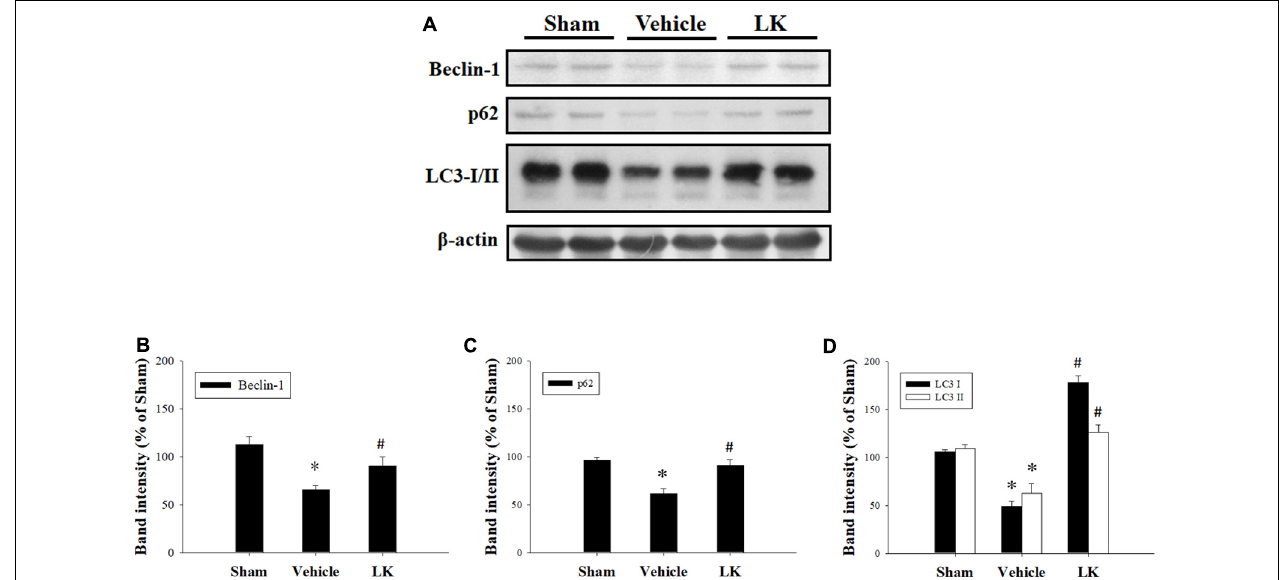
FIGURE 6 | Post-ischemic lumbrokinase treatment enhanced autophagic flux in rats subjected to myocardial I-R injury. (A) Representative images of the Western blot results. Quantitative densitometric analysis of (B) Beclin-1, (C) p62, and (D) LC3-I/II protein expression in rat myocardium after myocardial I-R injury. Data are normalized with values from the sham group and presented as percentage rates. Each value is represented as the mean ± SEM ( n = 3). ∗ p < 0.05 compared with the sham group; # p < 0.05 compared with the vehicle group.